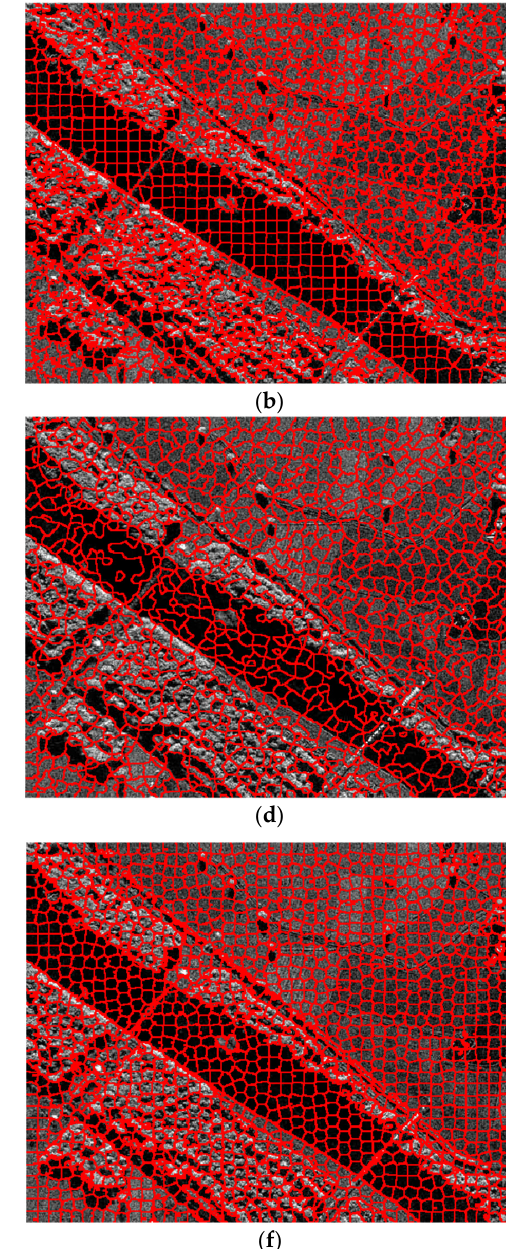
SI . ( a ) SLIC, ( b ) SNIC, ( c ) SEEDS, 5